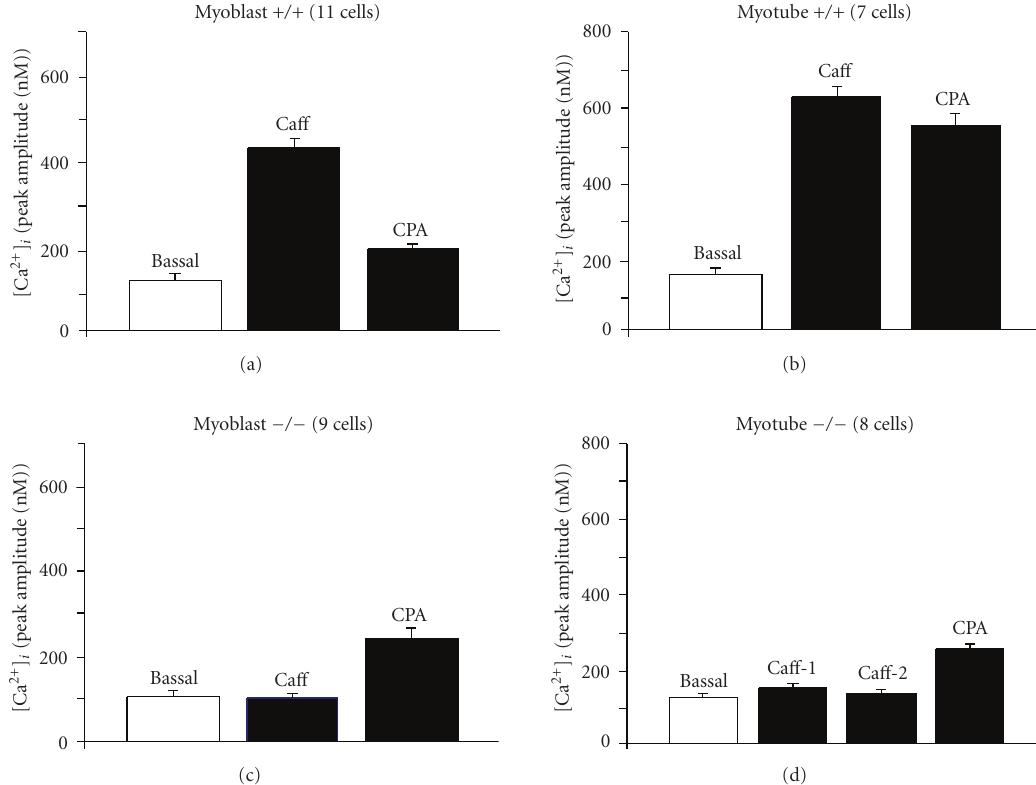
Figure 5: Peak amplitude of [Ca 2+ ] i response of myoblasts and myotubes to ca ff eine and CPA. Bar diagrams summarize the response of the cell types shown in Figure 4. (a) myoblasts (+/+); (b) myotubes (+/+); (c) myoblasts ( − / − ): application of 20mM ca ff eine followed by 10 μ M CPA; (d) myotubes ( − / − ): 2 successive applications of 20mM ca ff eine followed by 10 μ M CPA. The number of cells tested is given in